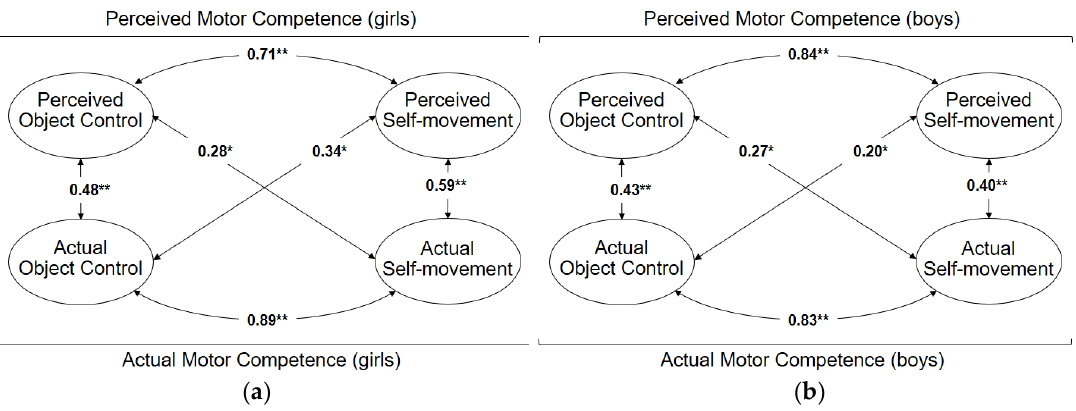
Figure 2. Relations between the factors of actual and perceived MC (model 3) ( a ) for girls; ( b ) for boys. * Significant di ff erences at the level of p ≤ 0.05; ** Significant di ff erences at the level of p ≤ 0.001.